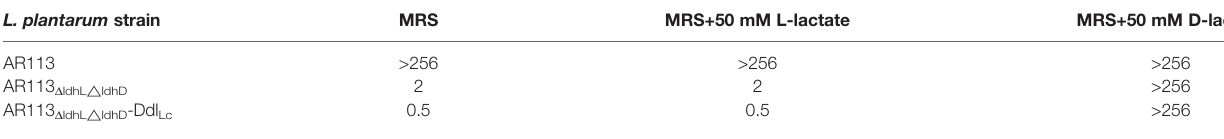
TABLE 2 | MICs of vancomycin in wild-type and mutant strains of L. plantarum ( m g/mL). L. plantarum